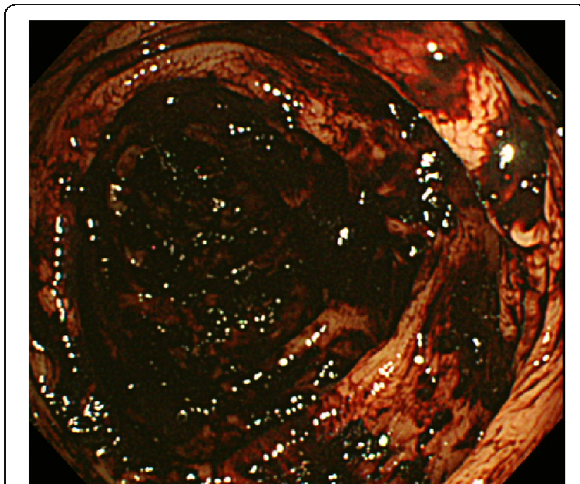
Fig. 1 Colonoscopic finding of unknown origin melena